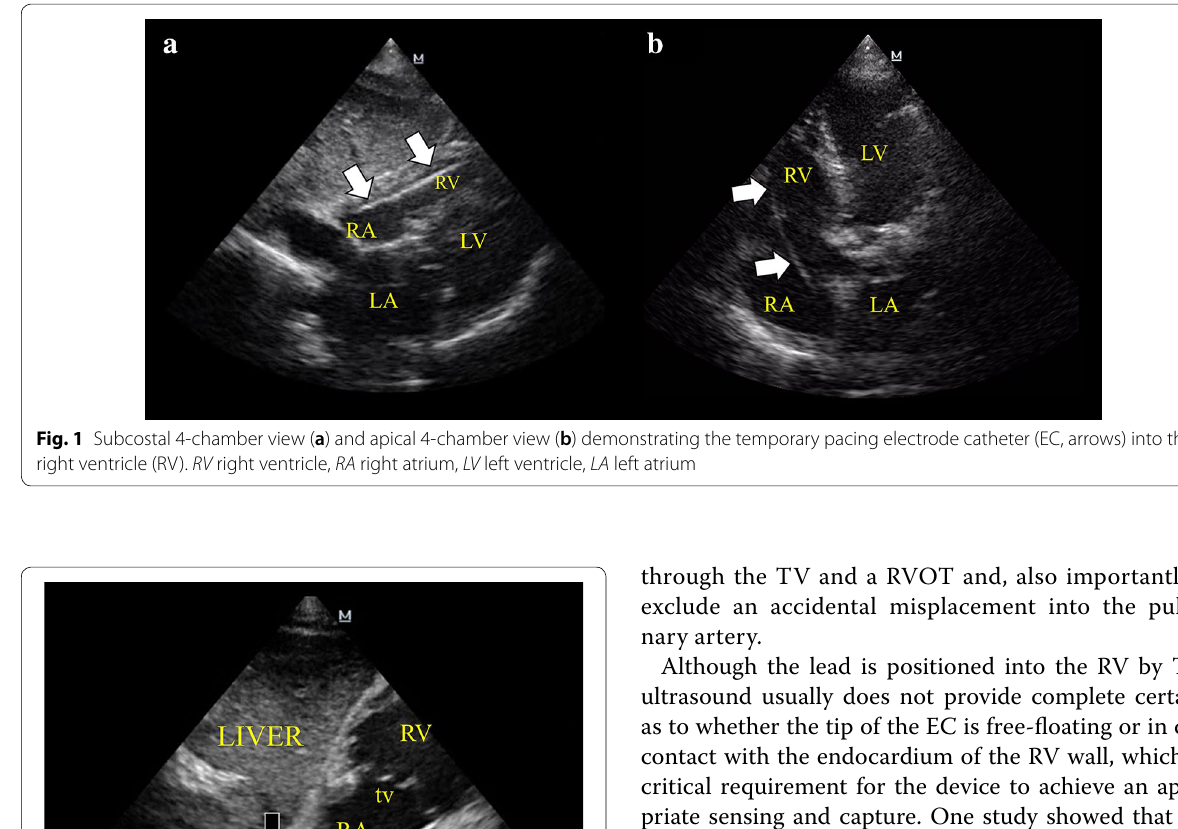
positions, although somewhat unstable, are the inter- ventricular septum, RV free wall, and RV outflow tract (RVOT). The inferior vena cava (IVC) view should be checked when, despite advancement of the EC, there is no apparent EC progression into the RV (Fig. 2 and Additional file 1: Videos S3). Due to the anatomic con- tinuity between the superior vena cava and IVC, the EC inadvertently passing into the IVC is the most fre- quent incorrect placement observed in practice. Short- axis views (subcostal and/or parasternal) at the level of the great vessels are useful to detect the EC passing